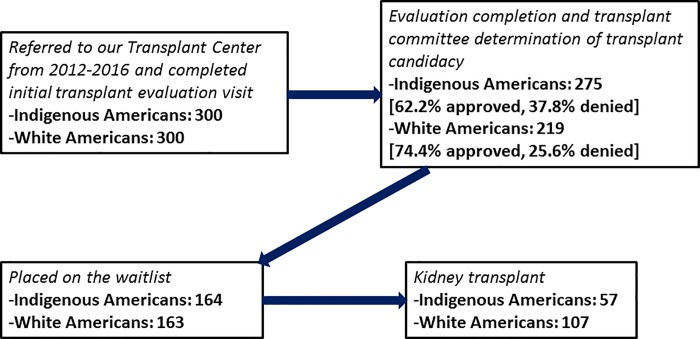
Flow chart of the outcome of the kidney transplant process for both groups.